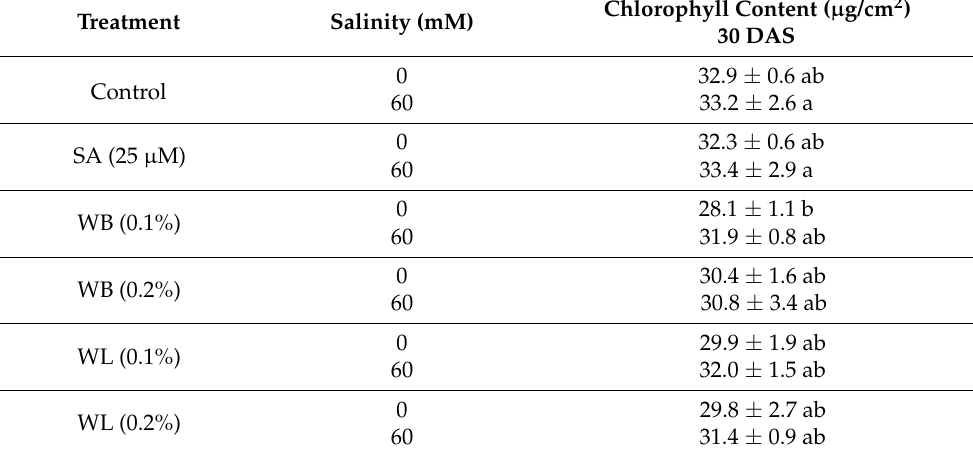
Table 2. Effect of treatments with various agents (SA, salicylic acid (25 µ M); WB, willow bark extract (0.1% or 0.2% w/v ); WL, willow leaf extract (0.1% or 0.2% w/v )) on chlorophyll content of 30-day-old maize ( Zea mays cv. Caramelo) plants hydroponically grown in control (0 mM) or salinity stress (60 mM)